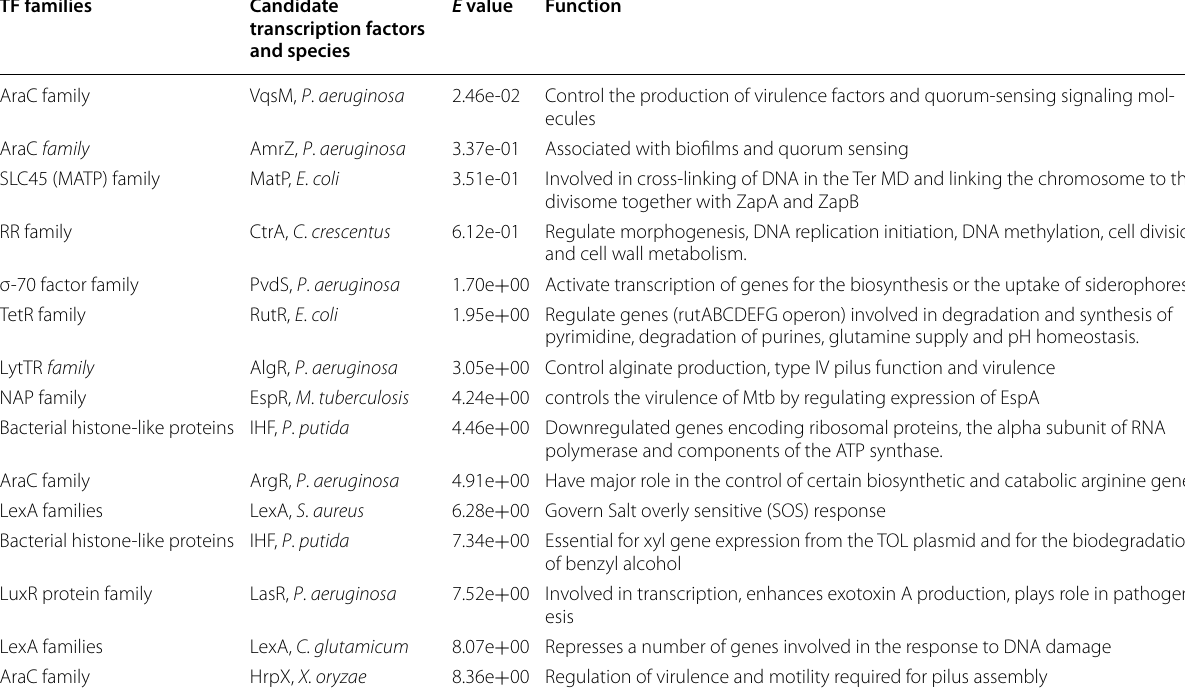
Table 3 Transcription factor families binding to MTF1 motif of the promoter regions from prokaryotic database and their roles TF